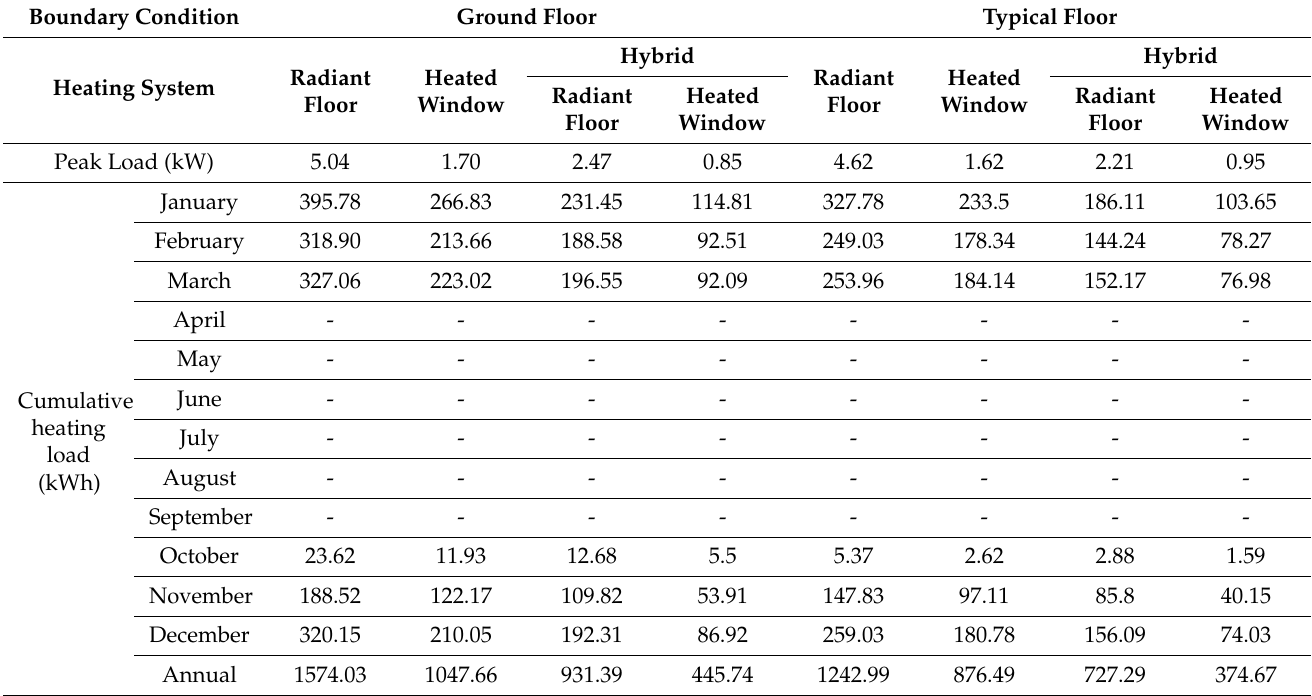
Table 7. Peak heating load and cumulative heating load of each simulation